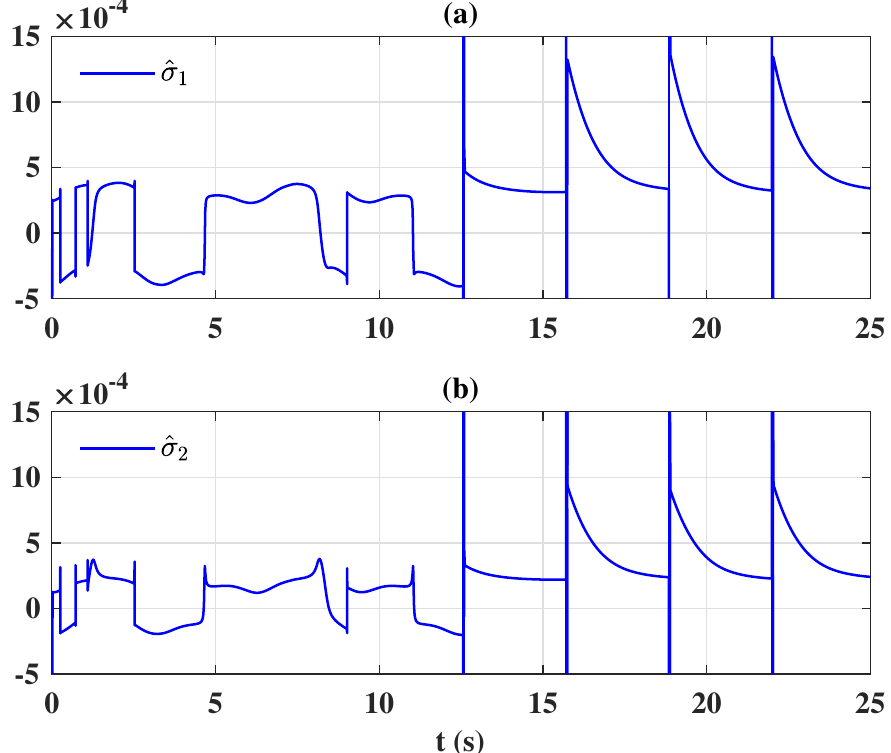
Figure 8. Time history of the sliding variables ( a ) ˆ σ 1 and ( b ) ˆ σ 2 with the extended references